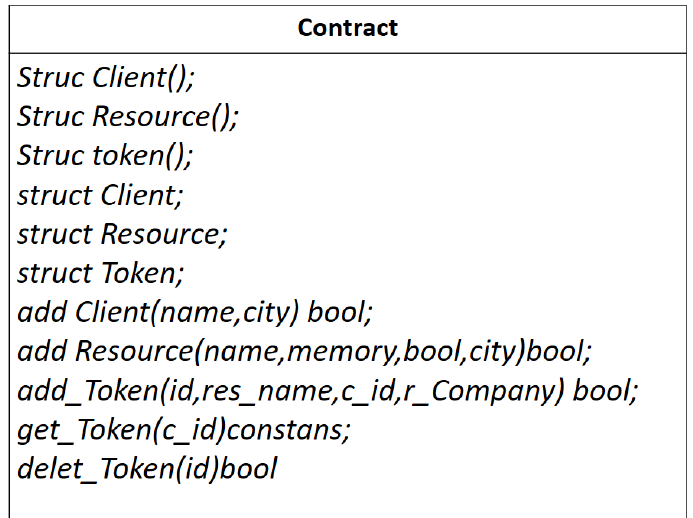
Figure 9. Smart contract deployed on the